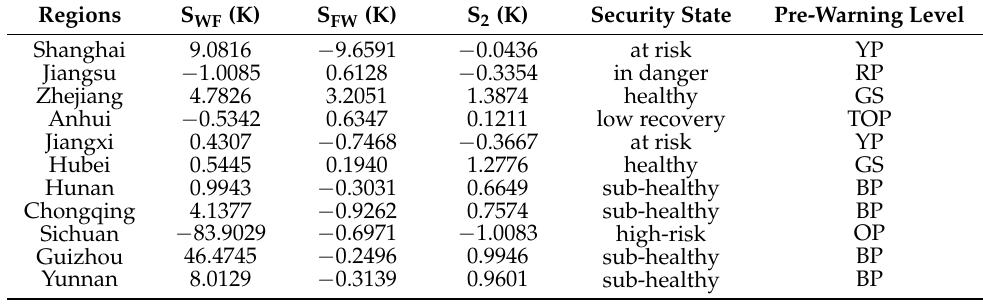
Table 4. Results of symbiotic security index from the perspective of water-food symbiosis. Regions